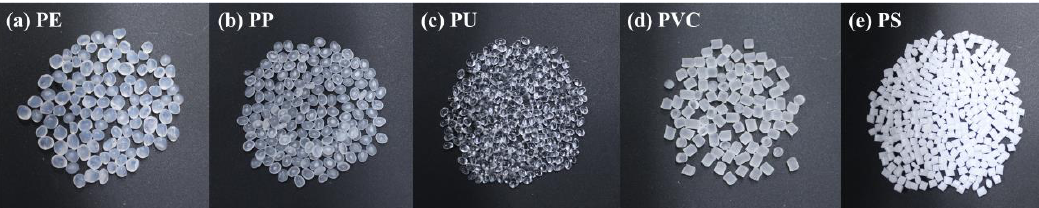
Figure 5. Photographs of polymer pellets ( a ) polyethylene, ( b ) polypropylene, ( c ) polyurethane, ( d ) polyvinyl chloride and ( e ) polystyrene.